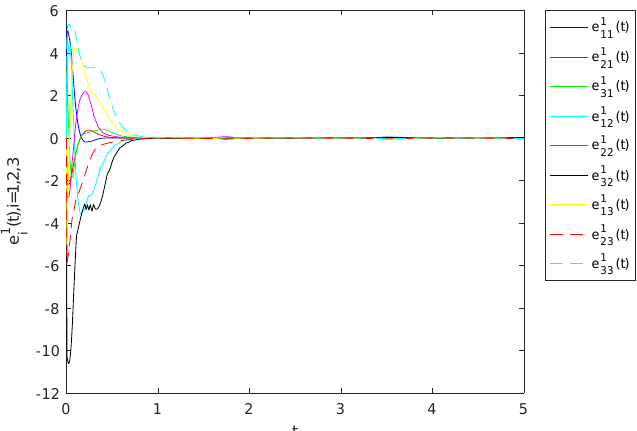
Figure 14. Synchronization error in the first layer under Controller (17).